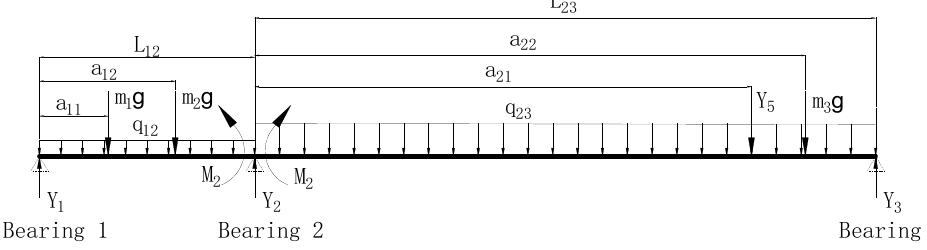
Figure 4. Applied forces of the outer rotor.